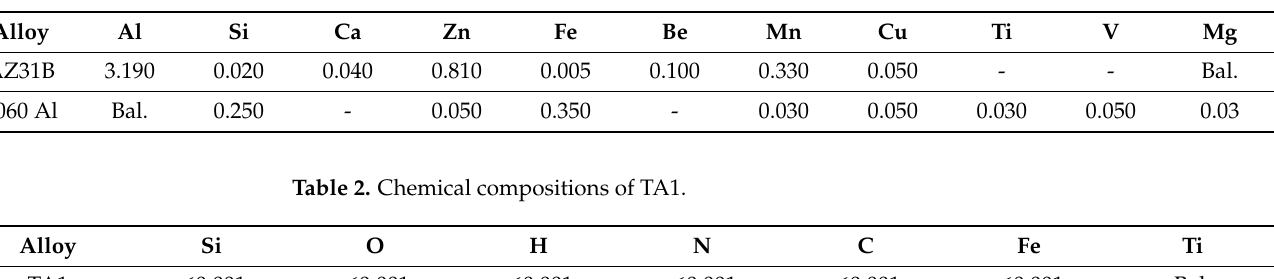
Table 1. Chemical compositions of AZ31B and 1060 Al (wt.%).